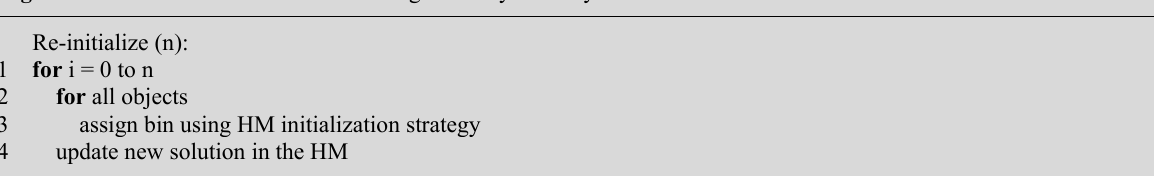
Algorithm 1: Pseudocode for Re-initializing harmony memory